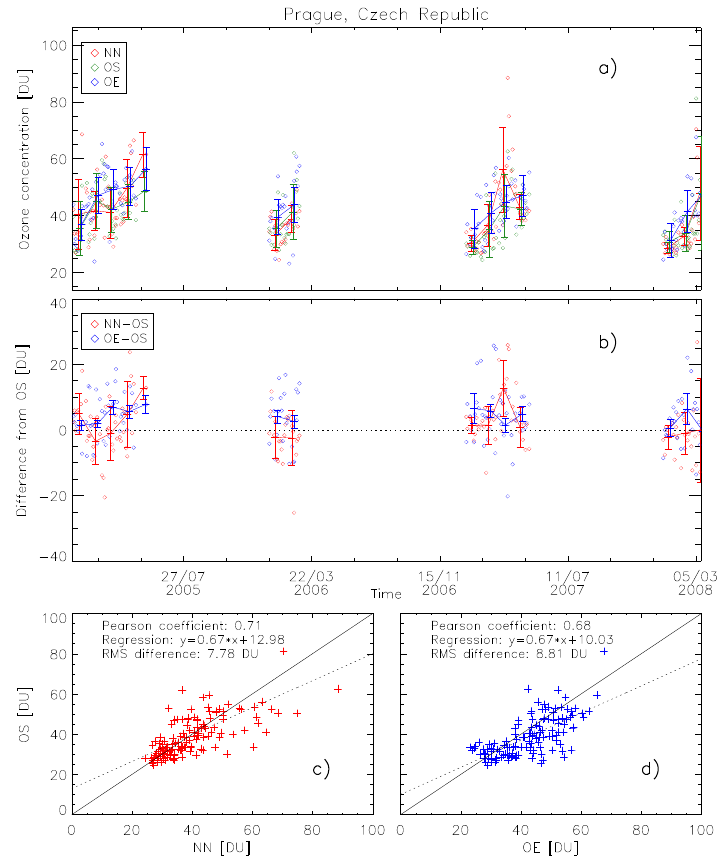
Fig. 8. Time series of OMI-TOC NN (in red) and OE (in blue) retrievals, and OS reference data (in green) (a); time series of absolute differences between OMI-TOC NN retrievals and OS (in red), and OE retrievals and OS (in blue). A monthly mean is over plotted (crosses with errorbars and lines) (b); scatter plot of OMI-TOC NN retrievals (in red) and OE (in blue) versus corresponding OS true data (c,d) for Prague, Czech Republic.